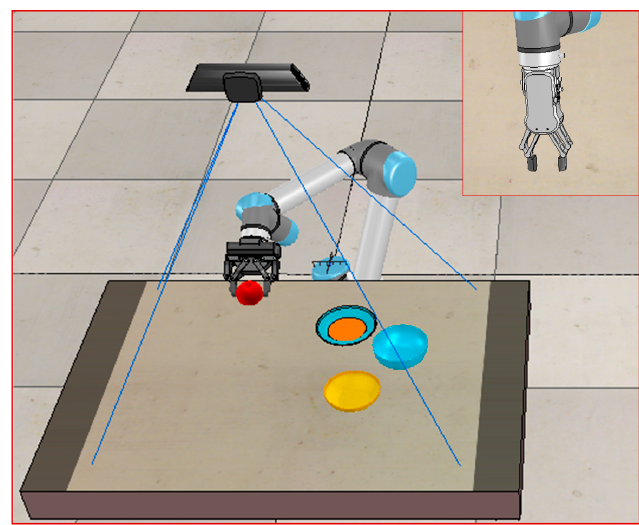
Figure 5. The object placing application scenarios in V-REP .